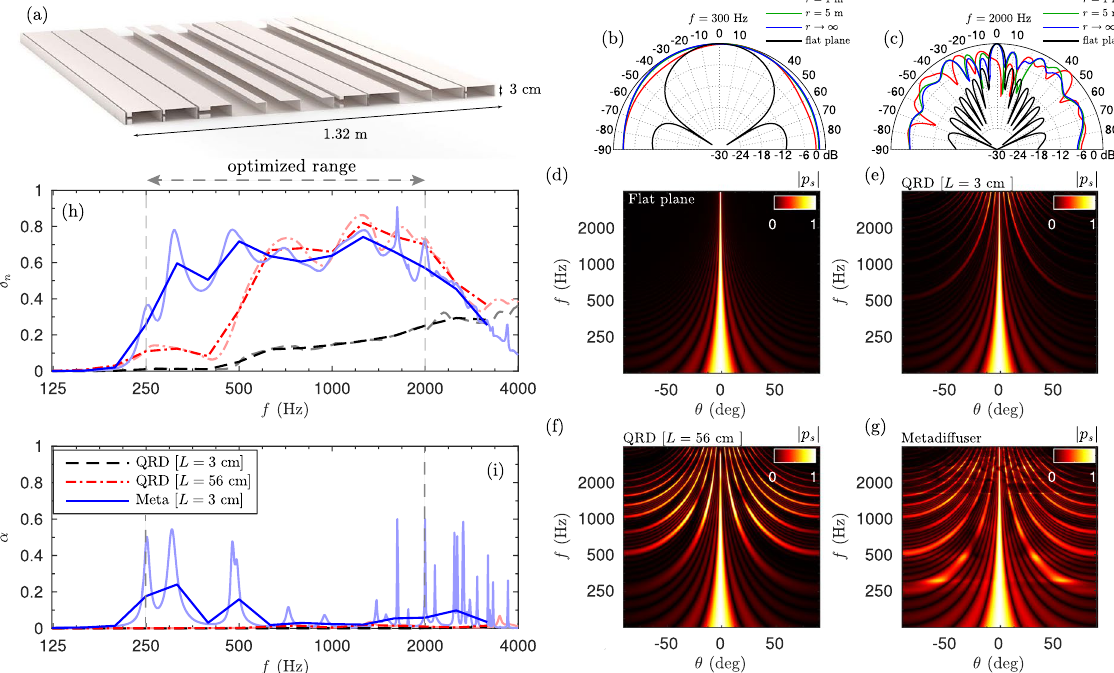
Figure 7. Far field polar response as a function of the frequency for ( a ) reference flat plane, ( b ) N = 11 QRD panel with a total thickness of 3 cm, ( c ) QRD panel with total thickness of 56 cm and ( d ) optimized metadiffuser thickness of 3 cm. ( e ) Normalized diffusion coefficient or the 3 cm QRD (dashed black), 32 cm QRD (dashed- dotted red) and optimized metadiffuser using TMM (blue) integrated in third of octaves. The third octave integration is shown in thick lines according to ISO 17497-2:2012 43 . ( f ) Corresponding